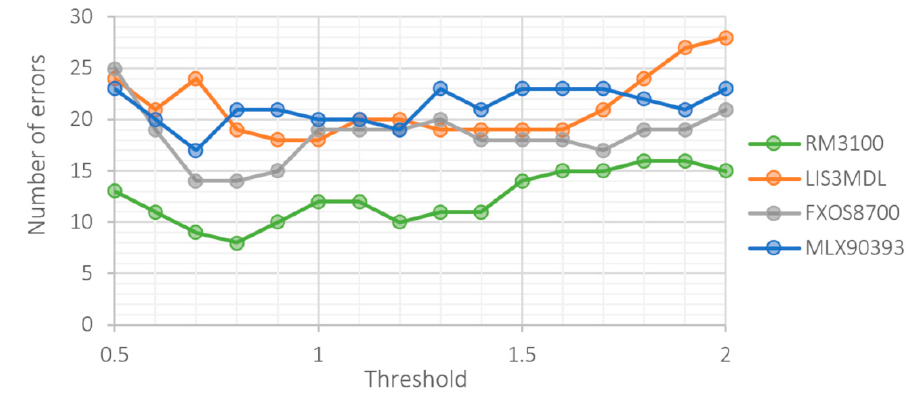
Figure 11. Total number of errors at different threshold level.